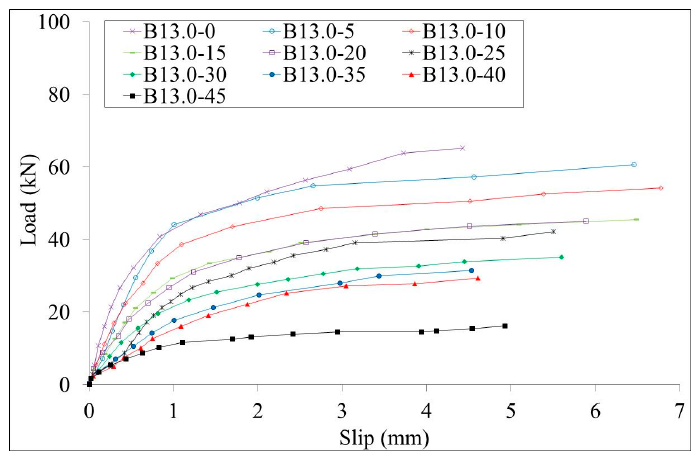
Figure 10. Load-slip curves of the B13.0 series specimens.